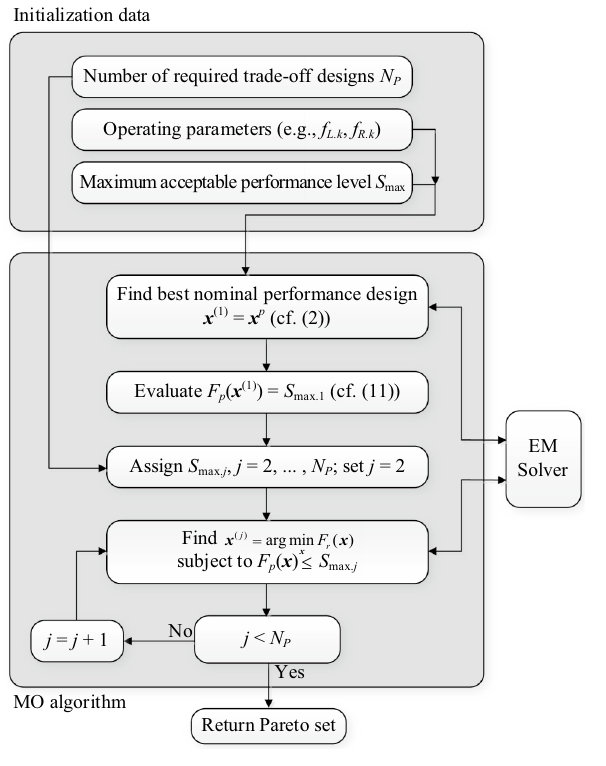
Figure 4. Operating flow of the proposed multi-criterial optimization algorithm with knowledge-based robustness evaluation using feature-based predictors and trust-region-based parameter